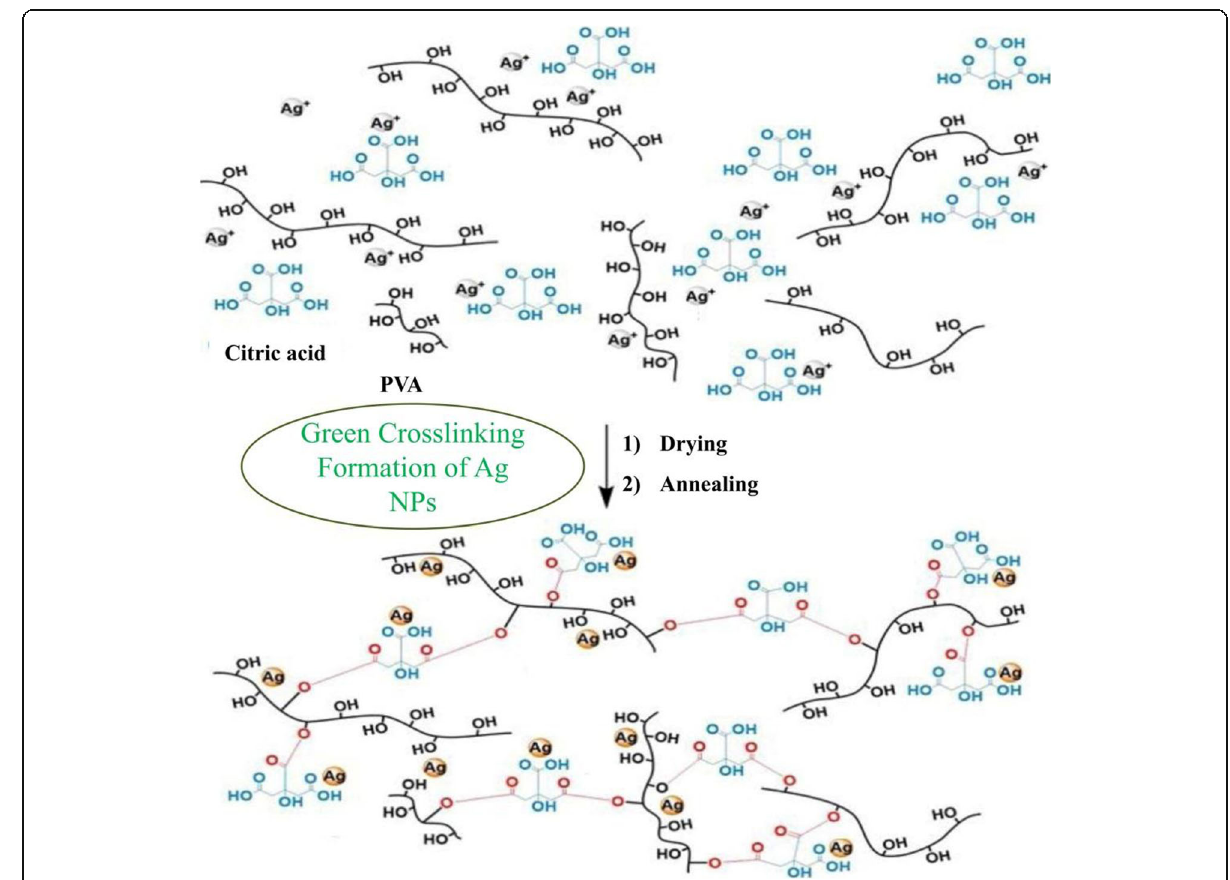
Fig. 3 Diagrammatic representation of simultaneous PVA cross-linking with CA and AgNPs formation. [ “ Reprinted (adapted) with permission